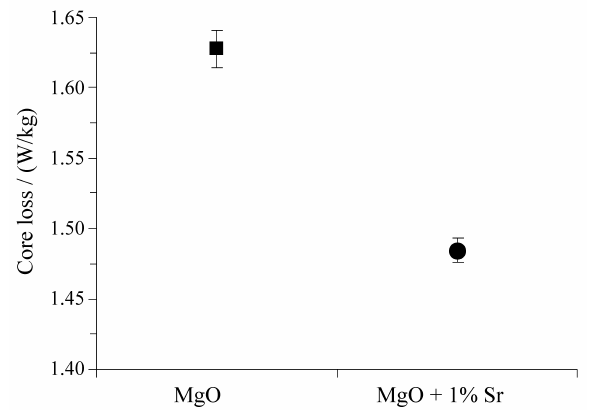
Figure 6. GDS intensity of Fe, Si and Mg as a function of depth from the outermost surface for the sample coated with a MgO + 1% Sr slurry.